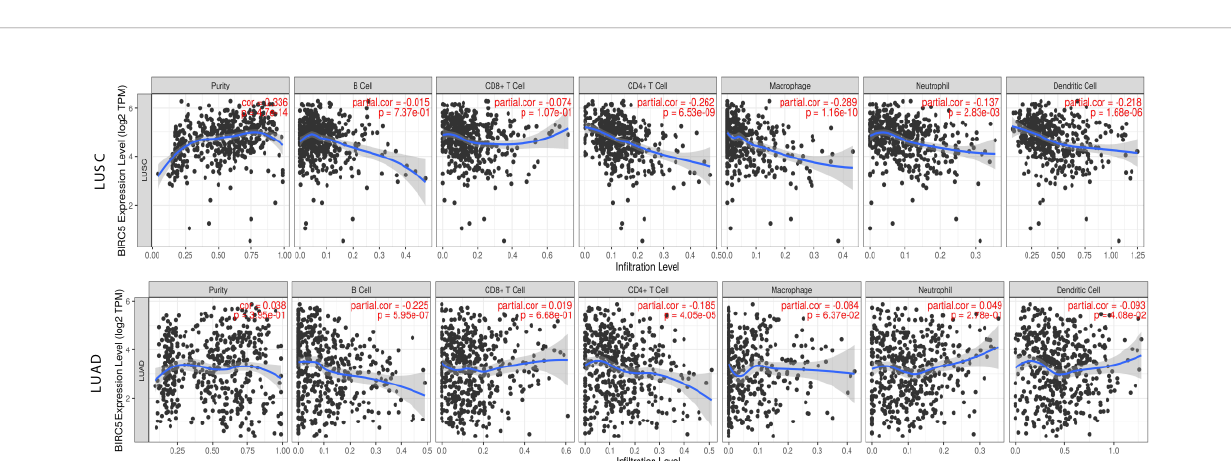
FIGURE 8 | Relationship between the transcriptional level of BIRC5 and immune in fi ltrates in LUSC and